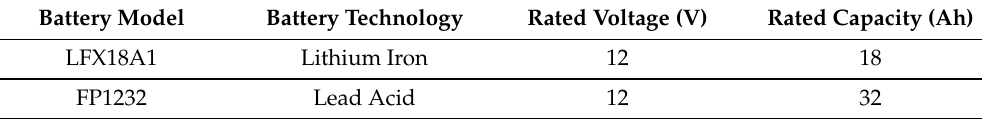
Figure 10. Assembled setup employing different electrochemical batteries. Table 5. Main data for the batteries used in bench